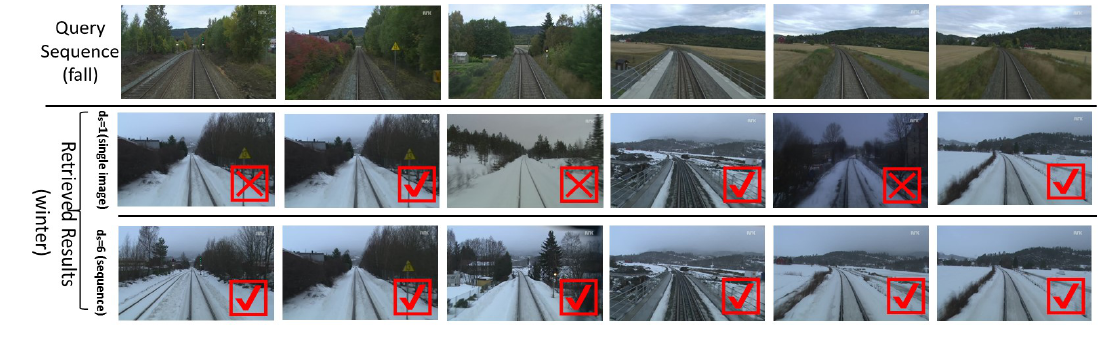
Figure 10. Frame match examples from the Nordland (fall vs. winter) data sets. The top row shows a query sequence, and the middle and third rows show the frames recalled by d s = 1 (single image) and d s = 6, respectively. Visual recognition based on sequence matching achieves a better performance than that of a single